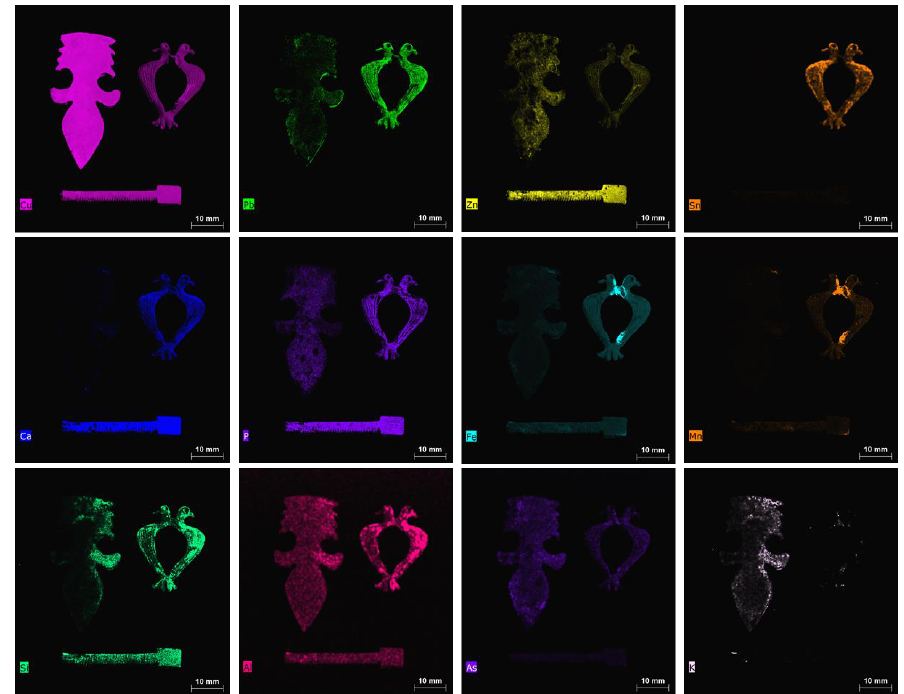
Figure 8. Elemental maps for the detected elements of applique, zoomorphic fibula, and spatula. The maps of S and Ti are not shown due to the extremely low contents of these two elements.